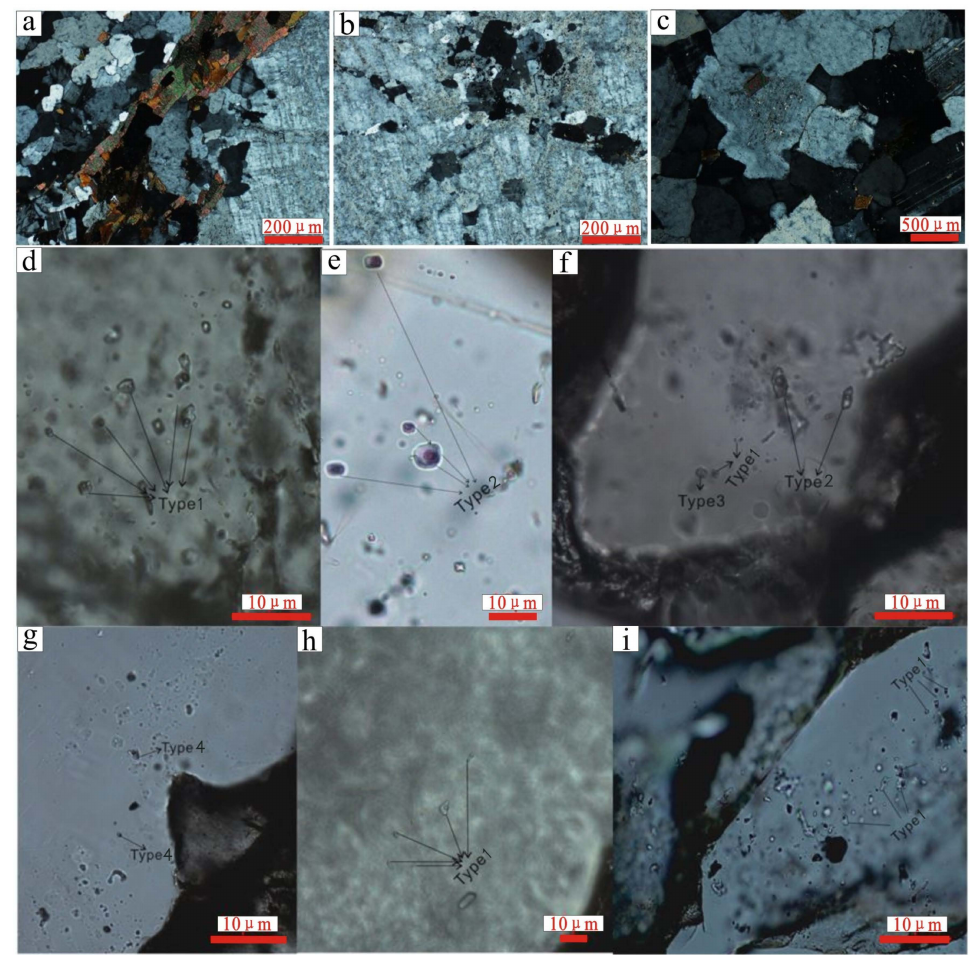
Figure 5. ( a – c ) Photomicrographs under cross-polarized light showing the micro-texture